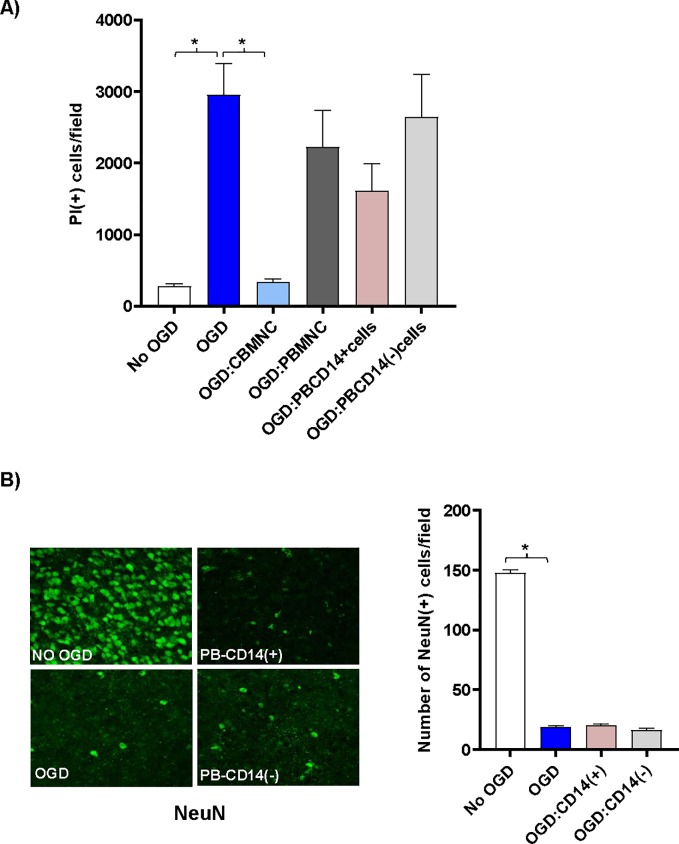
CD14+ CB, but not PB, monocytes protect neurons following OGD shock.(A) CB-MNC, PB-MNC, CD14+ or CD14 depleted PB cells (25,000cells/slice) were added directly onto OGD shocked brain slice cultures as indicated, and PI-positive cells dead were quantified and graphically represented. Statistically significant differences determined by one-way ANOVA (p<0.001) compared to the OGD control are indicated by asterisks. (B) Confocal images (40x) of antibody stained neurons [green, anti-NeuN] of control and cell treated brain slice cultures co-cultured three days with various PB cell populations following OGD shock. Top left panel shows control slices not exposed to OGD and cultured without human cells. All other panels show slices exposed to OGD prior to addition of human cells. Top right panel shows slices co-cultured with PB-CD14+ monocytes; bottom right panel, with PB MNC depleted of CD14+ monocytes. In the right panel bar-graph plot is shown, the average number of NeuN+ neurons, within sequential 40x high-powered fields located along the periventricular region was determined. Values shown are means +/- standard deviation. n = 3 slices under each condition. Statistically significant differences (p<0.01) compared to the OGD control are indicated by asterisks.